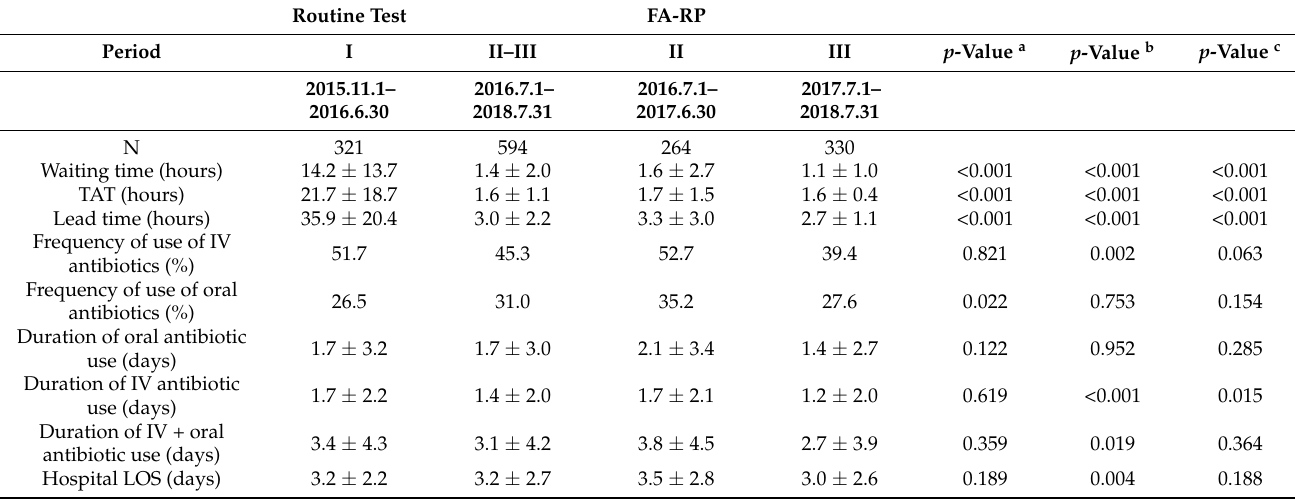
Table 4. Comparison of antibiotic use and hospital stay according to mPCR test and